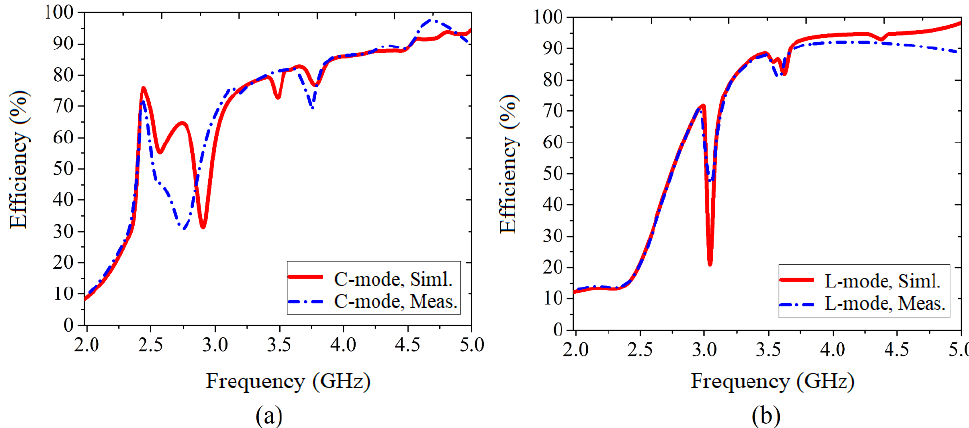
Figure 19. The simulated and measured antenna efficiency plots of the proposed antenna configura- tion: ( a ) C-mode and ( b )